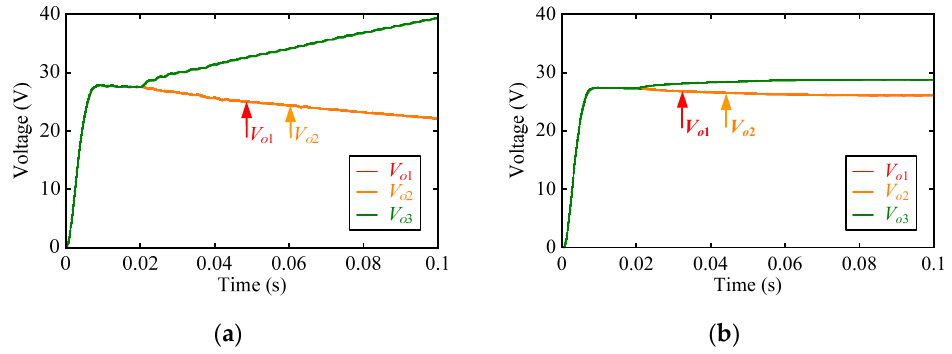
Figure 6. Output voltage waveforms under load fluctuation conditions. ( a ) Without parameter optimization. ( b ) With parameter optimization.